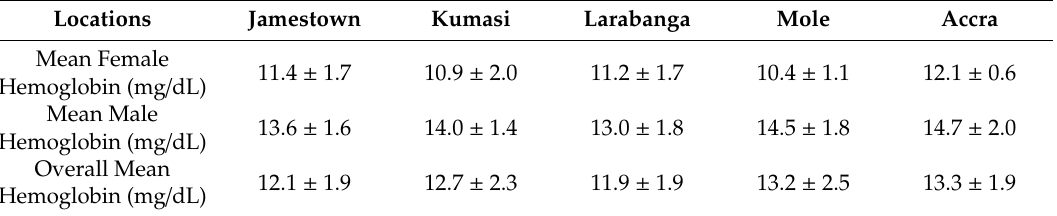
Table 1. Average hemoglobin of the five study locations, with standard deviation.